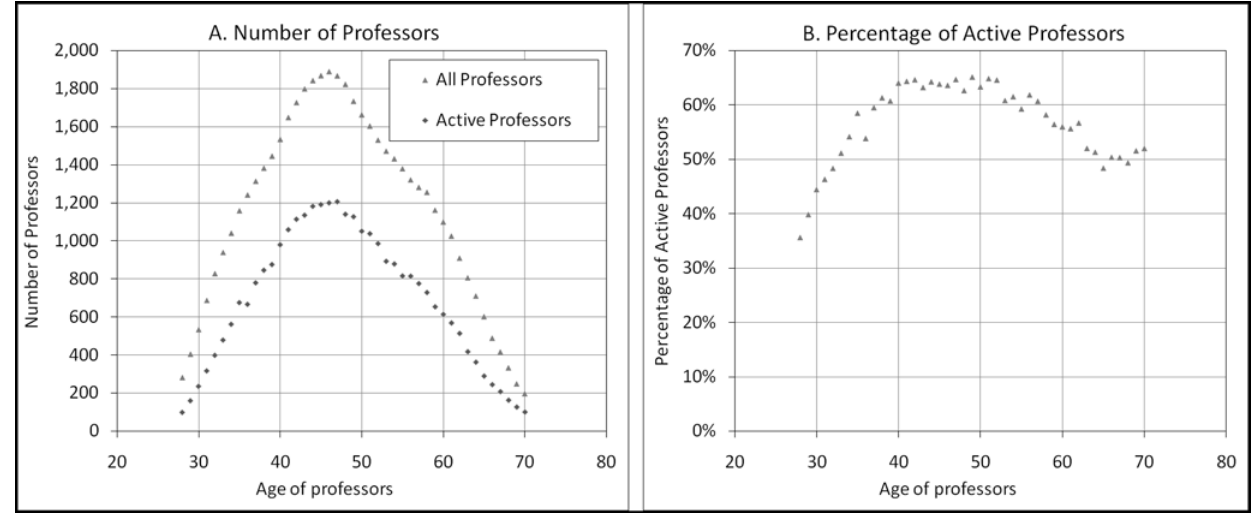
Figure 1. Distribution of professors by age. A) Number of professors (all professors and active professors) B) Percentage of professors who published at least one paper (active professors).